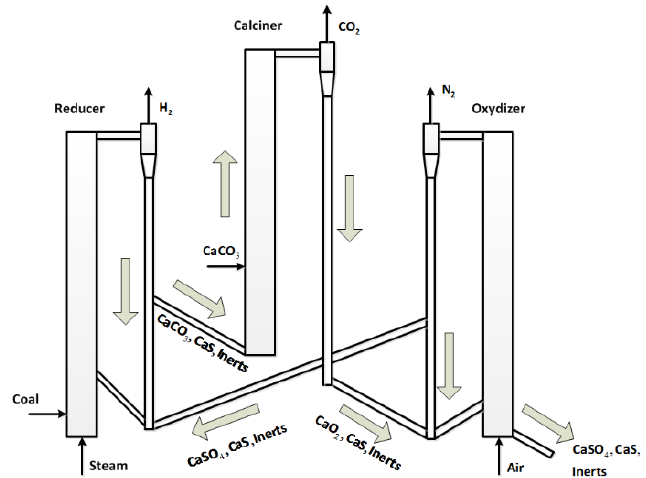
Figure 1. Alstom’s combustion-gasification process.